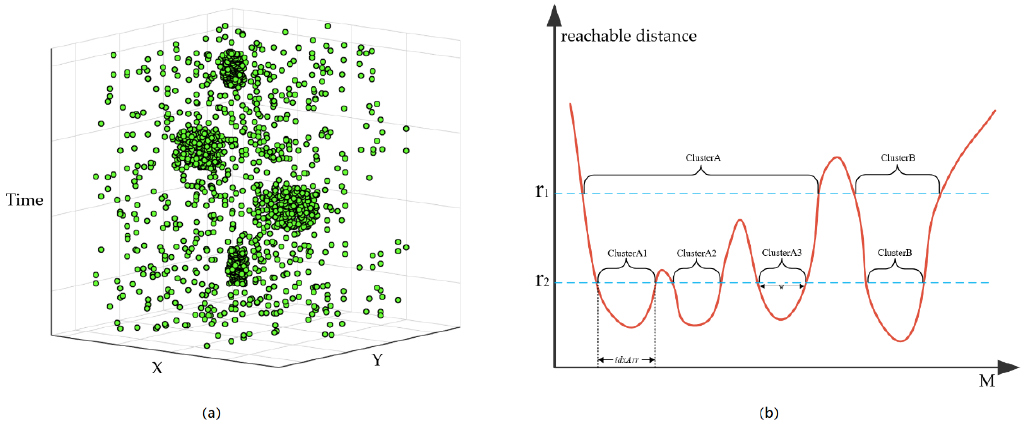
Figure 5. Detection process of the Indoor-STOPTICS algorithm: ( a ) reconstructed trajectory point set 𝐷𝐵 and ( b ) decision graph of point set 𝐷𝐵 .